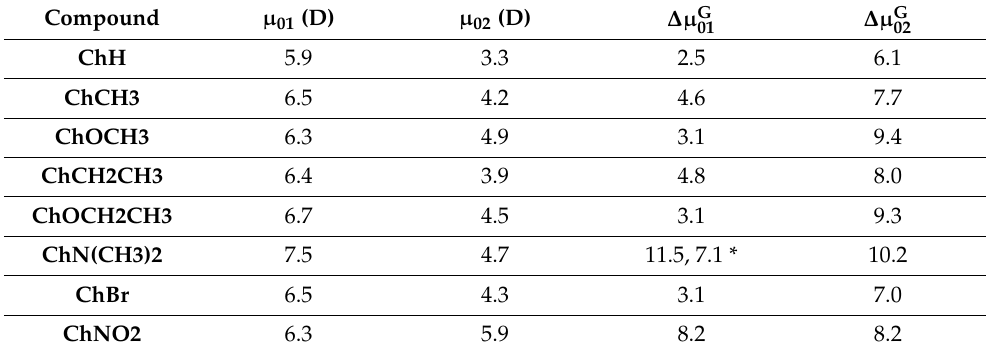
Table 2. Photophysical parameters used as input parameters in the SOS approach and transition dipole moment from the first to the second excited state ( µ 12 ) determined as adjustable parameters in represent the value of ∆ µ 01 obtained through QCCs. The asterisk the SOS approach. ∆ µ G and ∆ µ G 02 01 indicates the value experimentally determined and previously discussed in this